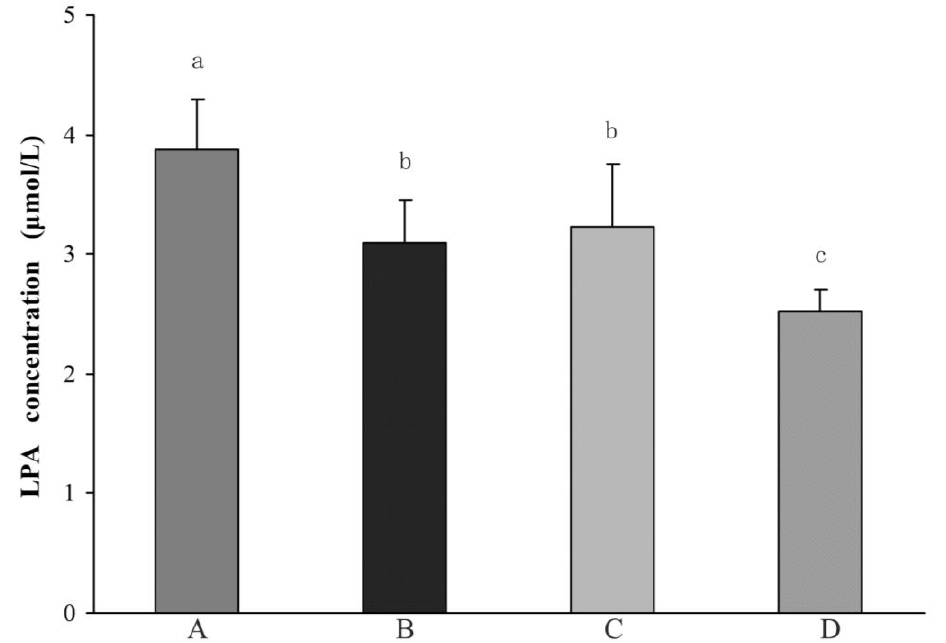
Figure 1. Comparison of LPA concentration (μmol/L) between the different study groups: ( A ) NVAF with SBI; ( B ) NVAF without SBI; ( C ) SBI without NVAF; ( D ) Control. Data are presented as means ± SEM. Columns relevant to each group bearing different superscripts (a, b or c) differ significantly ( p <